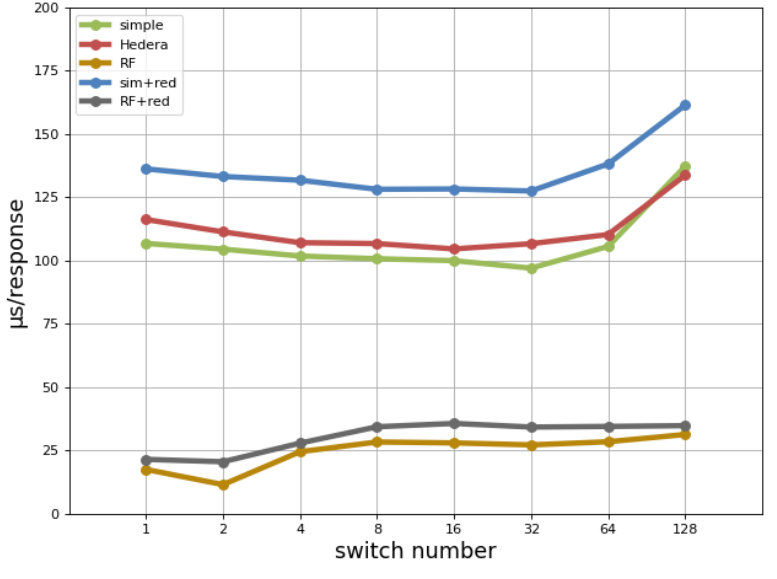
Figure 2. Latency Test under Various App Combinations And Switch